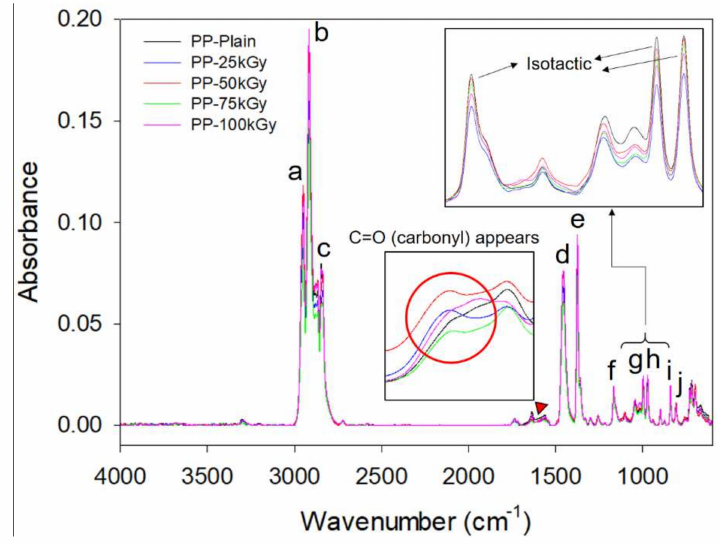
Figure 14. FT-IR spectra of polypropylene (PP) aggregate with different irradiation doses.